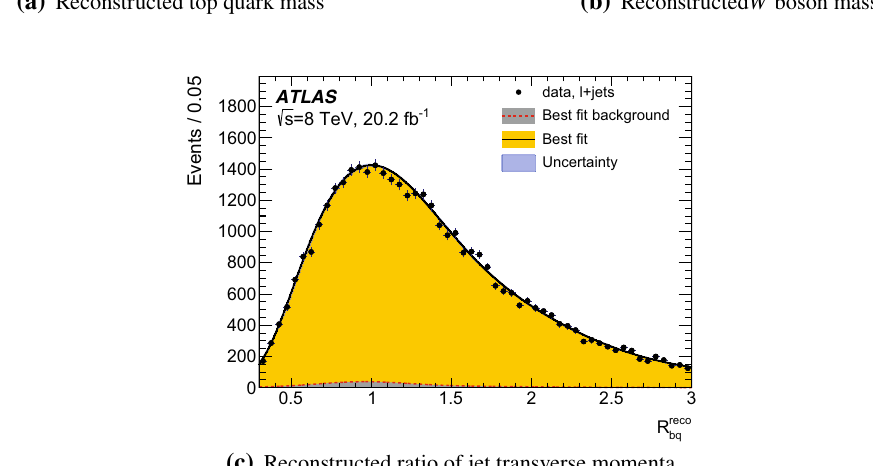
standard deviation total uncertainty in the fit function. It is based on the total uncertainty in the three fitted parameters as explained in the text. a shows the distribution of the reconstructed top quark mass m reco shows the distribution of the reconstructed W boson mass m reco shows the reconstructed ratio of jet transverse momenta R reco